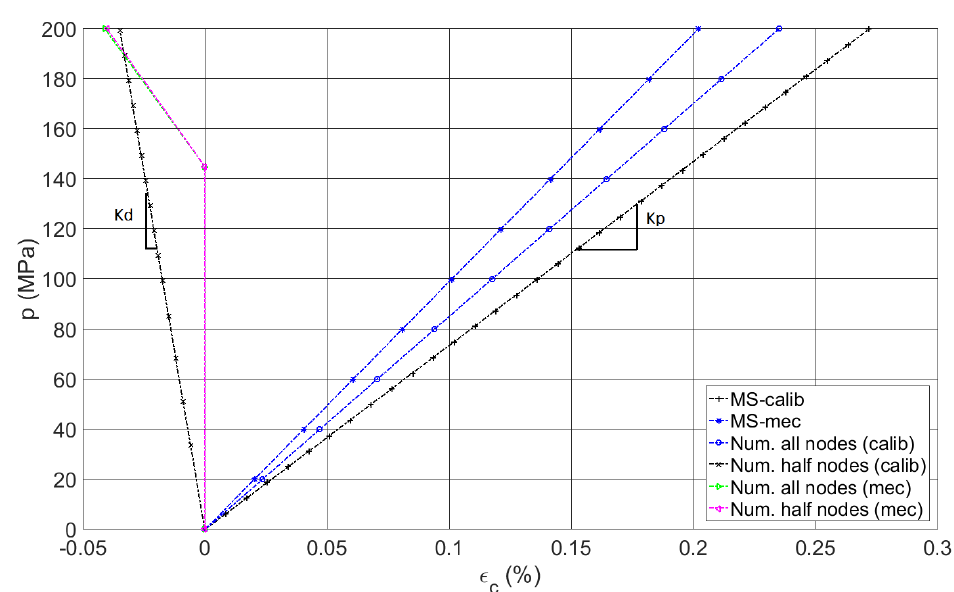
Figure 12. Experimental results of calibration test compared with the numerical calculations during a hydrostatic